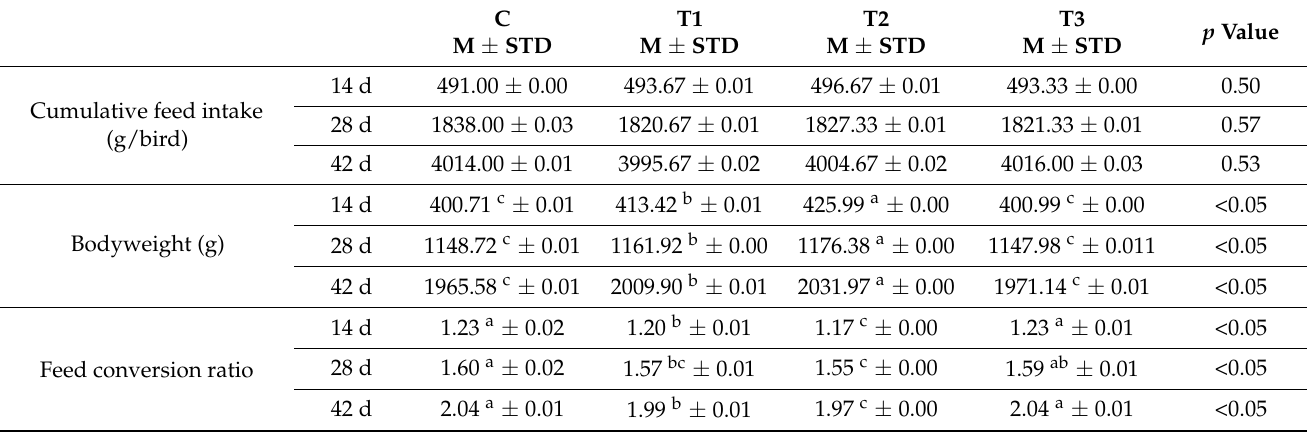
Table 2. Effects of oils on performance indices of broilers at different